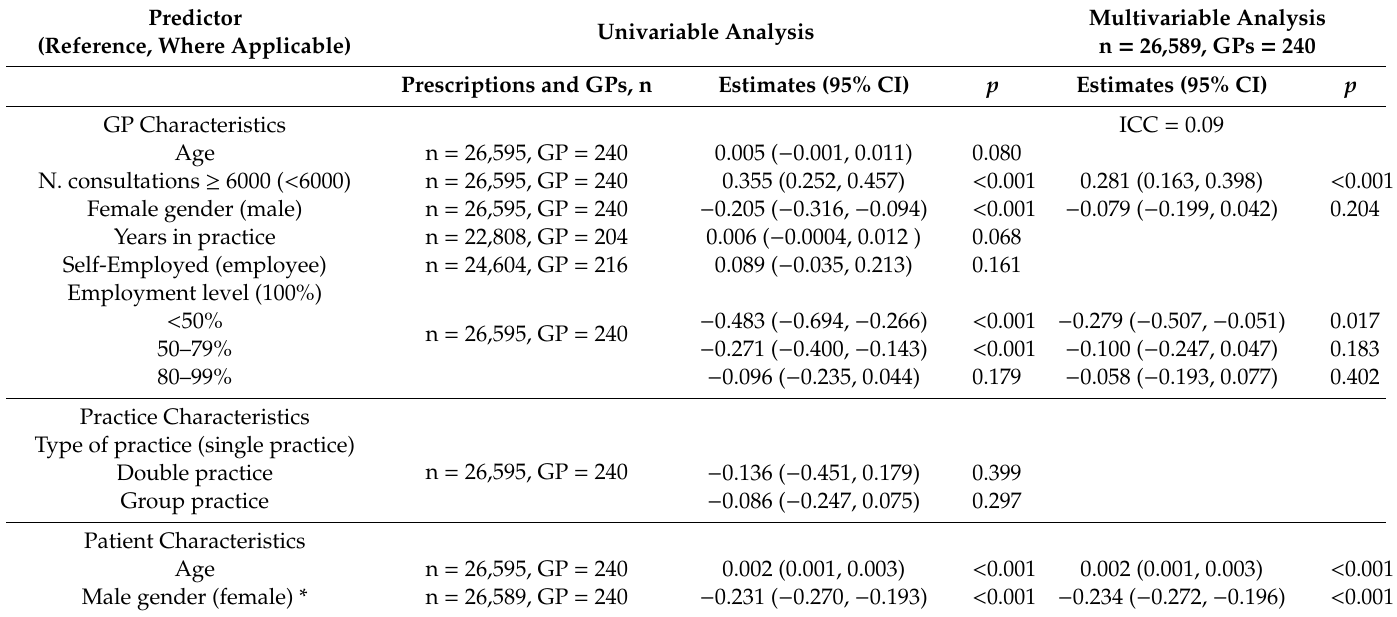
Table 4. Mixed model regression analysis on antibacterial prescriptions in